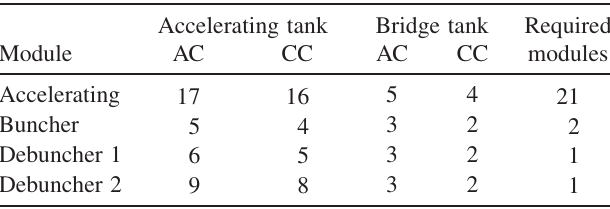
TABLE I. The number of accelerating and coupling cells, and the required number of modules. AC and CC stand for accel- erating cell and coupling cell, respectively.